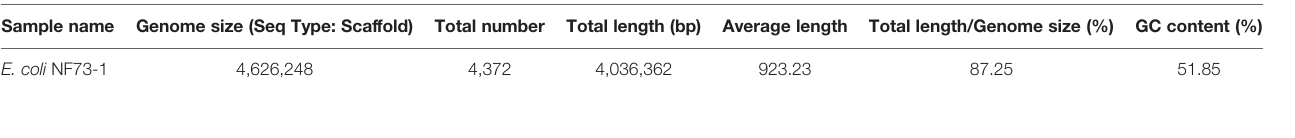
TABLE 5 | General genome information of E.coli NF73-1.